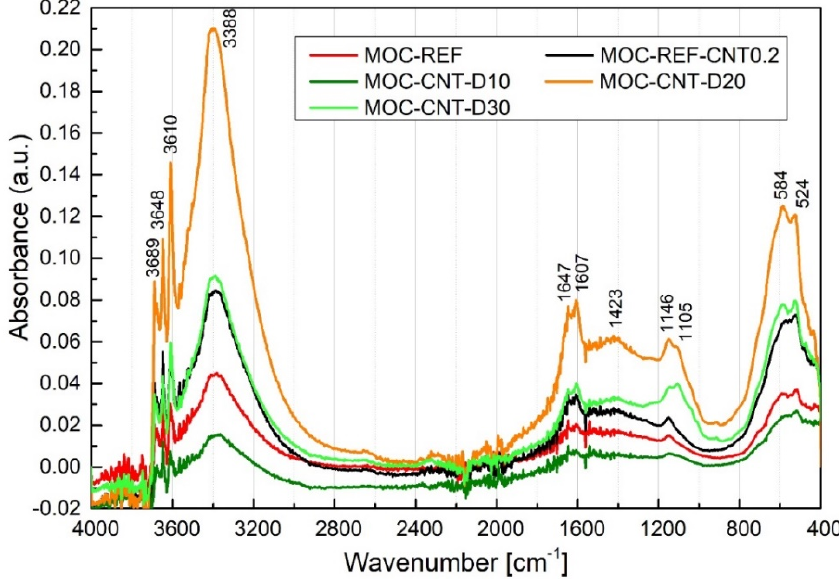
Figure 6. The MIR spectrum of tested composites in the range of 400–4000 cm − 1.